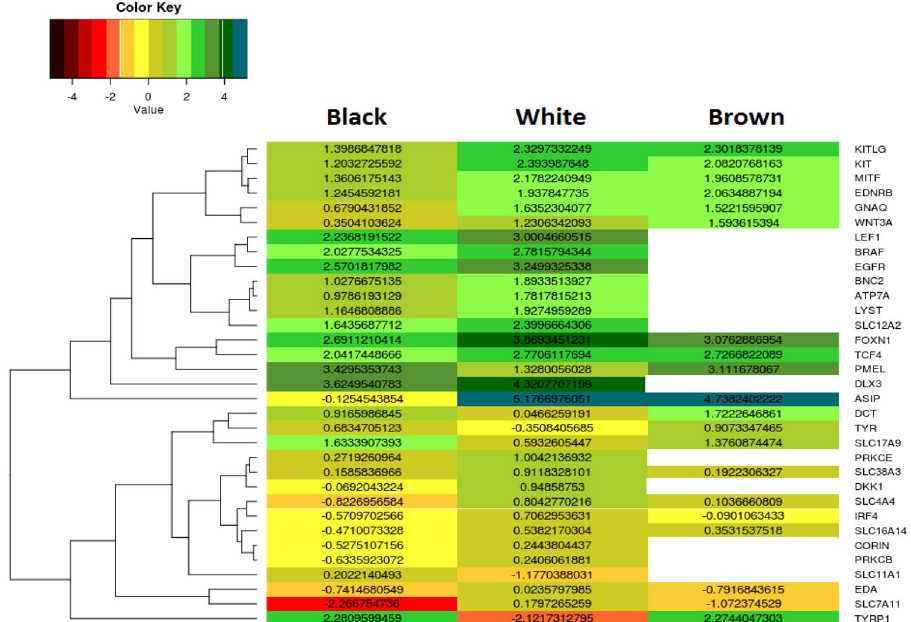
Figure 3. 2D – Hierarchical clustering analysis exploring the difference in gene expression between White, Black and Brown Pashmina fiber. Each row in the map represents a differentially expressed gene and column represents condition used. Log10(FPKM) value is used for constructing heat-map. Blank space specifies gene is not significantly expressed in a particular